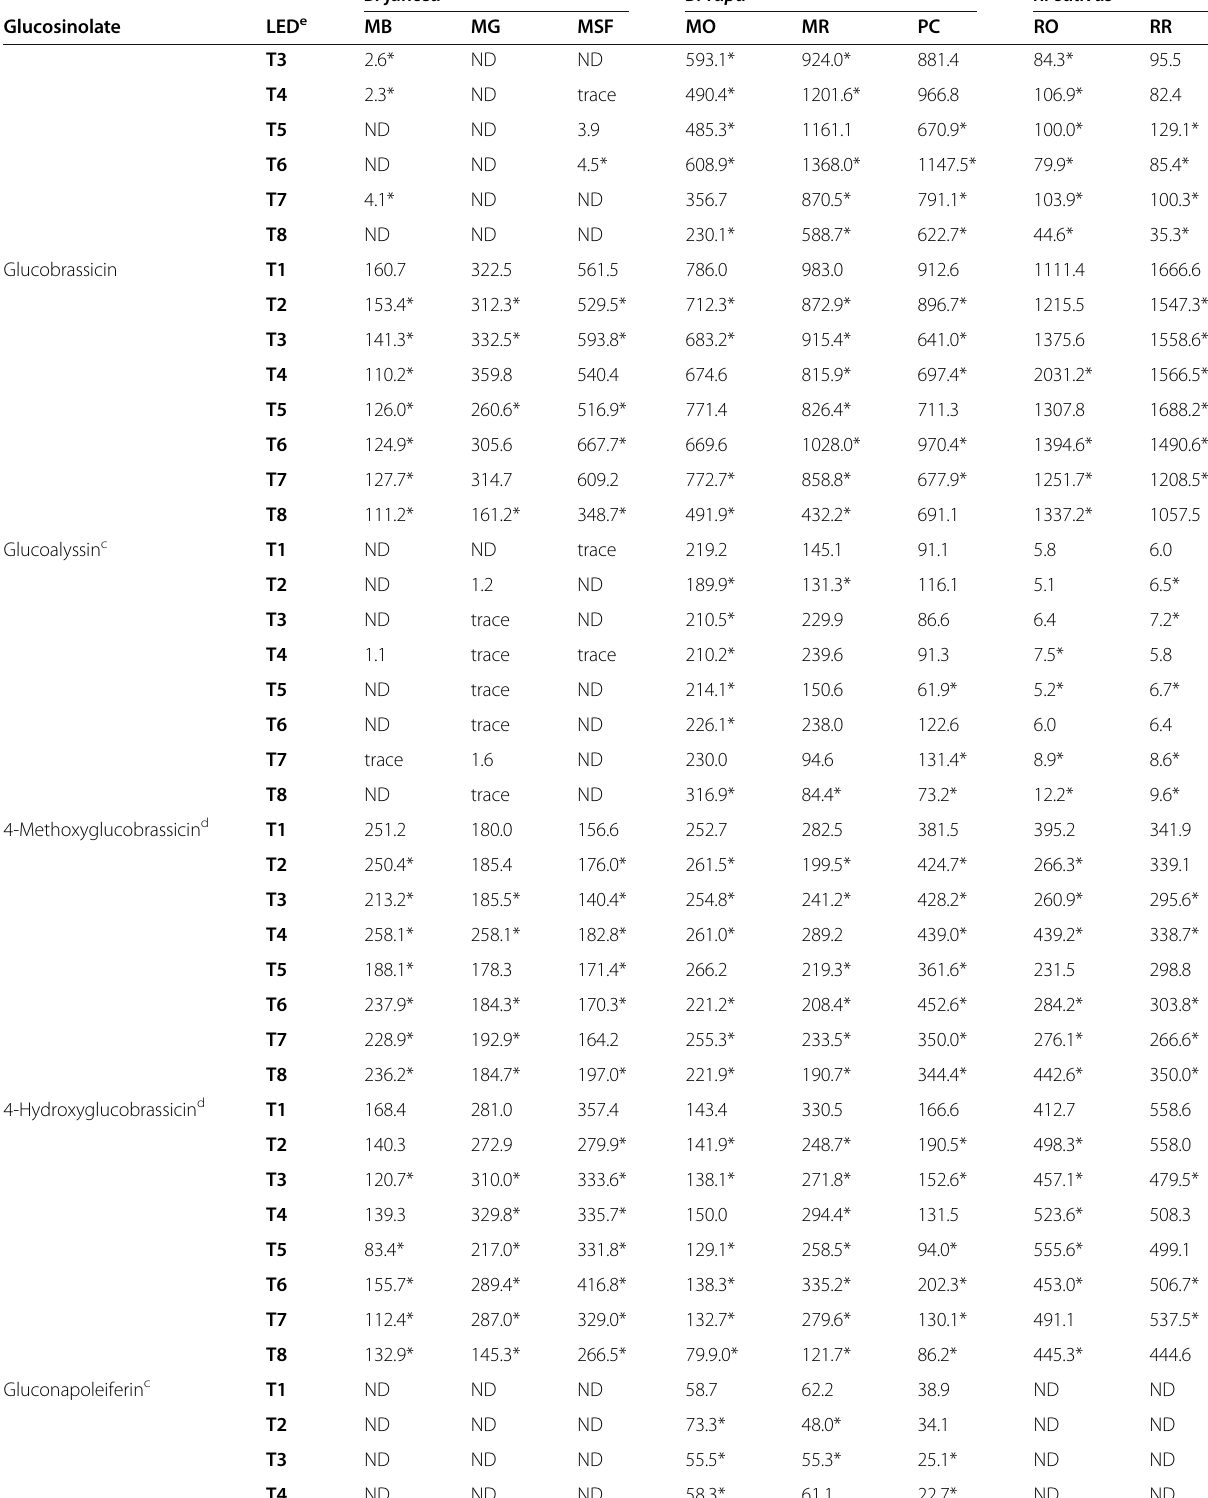
Table 3 Concentration of the glucosinolates identified in the microgreens under combined red, blue and amber LED. a Values are expressed as μ g sinigrin b , glucobrassicin c or gluconasturtiin d equivalents per g of microgreens (dry weight)